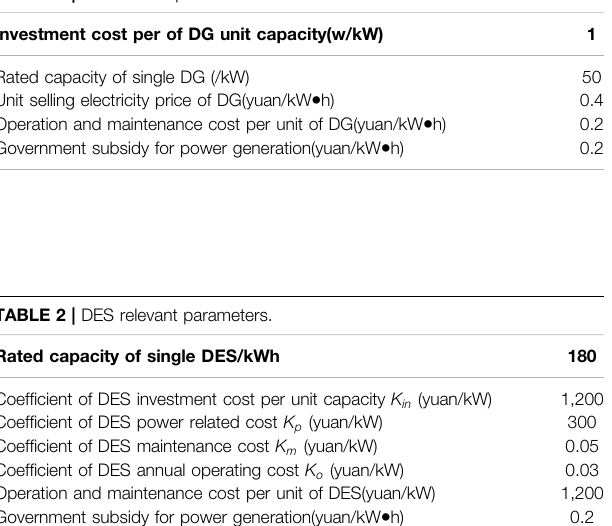
TABLE 1 | DG relevant parameters.